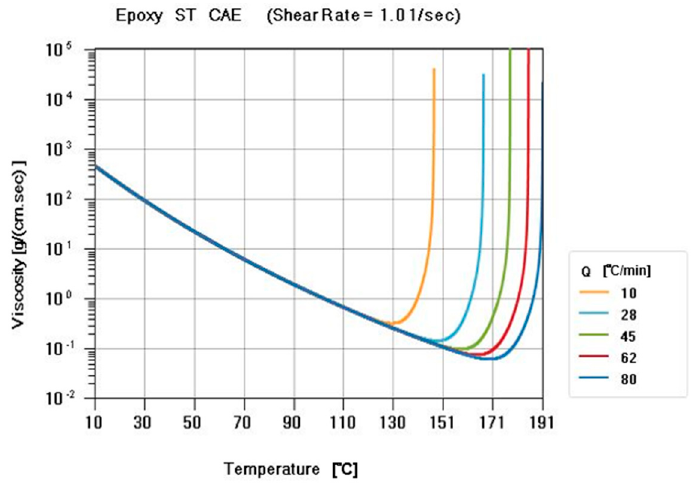
Figure 2. Viscosity curve of the ST resin. The viscosity was measured by a parallel-plate rheometer at different temperature ramping rates (Q = 10 °C/min; 28 °C/min; 45 °C/min; 62 °C/min; and 80 at different temperature ramping rates (Q = 10 ◦ C/min; 28 ◦ C/min; 45 ◦ C/min; 62 ◦ C/min; and °C/min), and the viscosity changed with time. 80 ◦ C/min), and the viscosity changed with time.